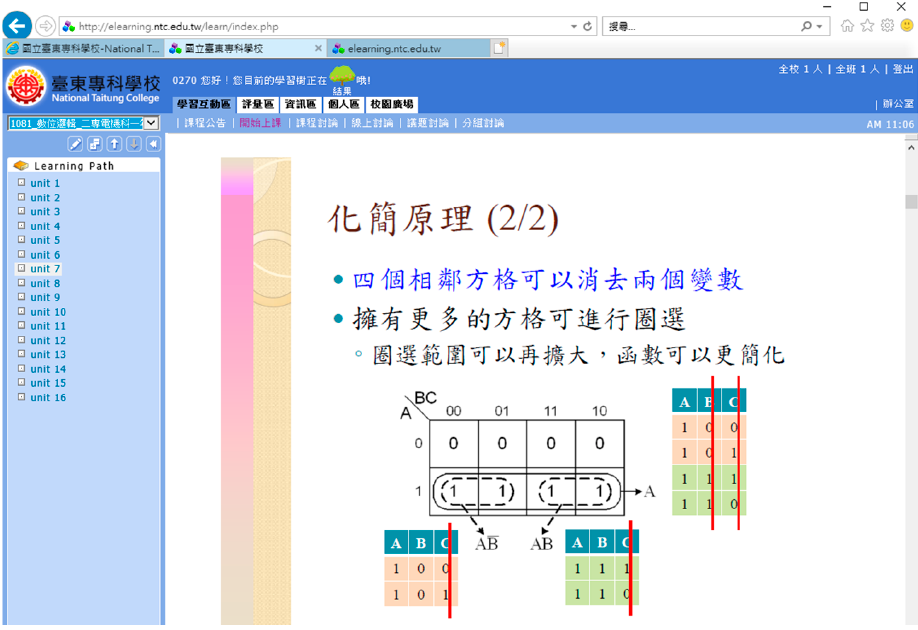
Figure 3. Digital logic course materials stored on the E-learning platform of a junior college in southeastern Taiwan: a snapshot of the slideshow in Unit 7.